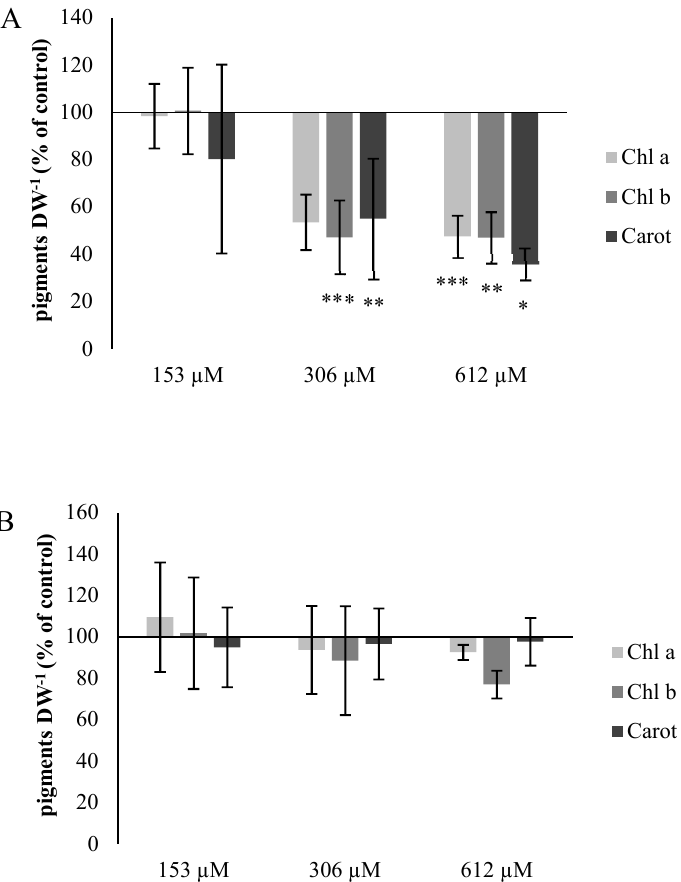
Figure 7. Pigments (chlorophyll a , chlorophyll b and carotenoids) content (percentage of control) of A. thaliana plants watered ( A ) and sprayed ( B ) with different concentrations of norharmane (0, 153, 306 and 612 µM) for 21 days. Asterisks indicate significant differences compared to the control (* p ≤ 0.05, ** p ≤ 0.01, *** p ≤ 0.001). Data are given in a percentage with respect to the control.